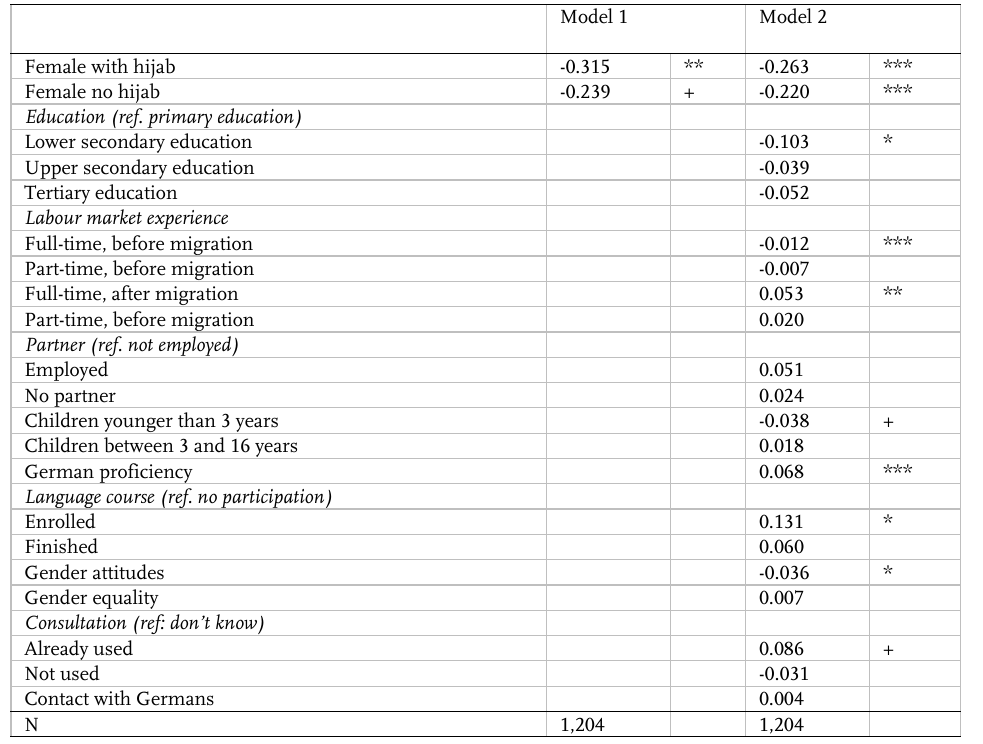
Table 2 : Results from logistic regression (1: Labour market participation; 0: No labour market participation), pooled models and models by gender, average marginal effects